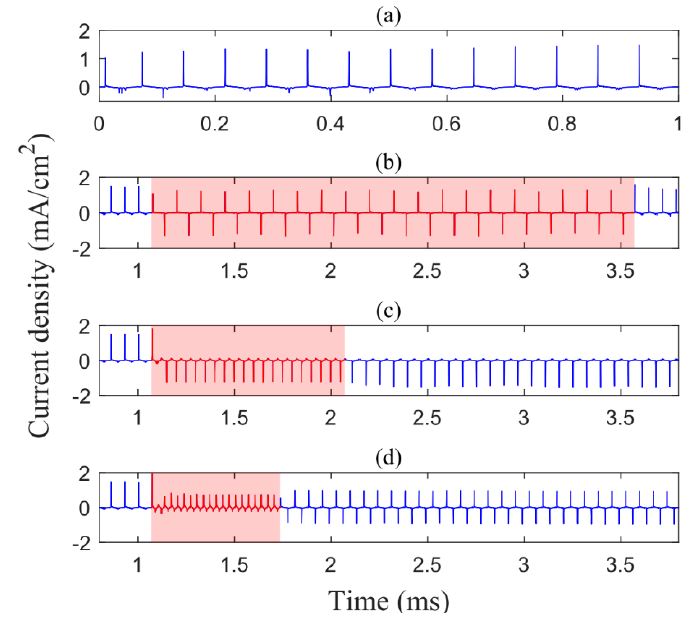
Figure 4. Temporal profiles of current density when the controlling frequency f c is set to be ( a ) 14 kHz, ( b ) 8 kHz, ( c ) 20 kHz and ( d ) 30 kHz respectively. ( b ) 8 kHz, ( c ) 20 kHz and ( d ) 30 kHz